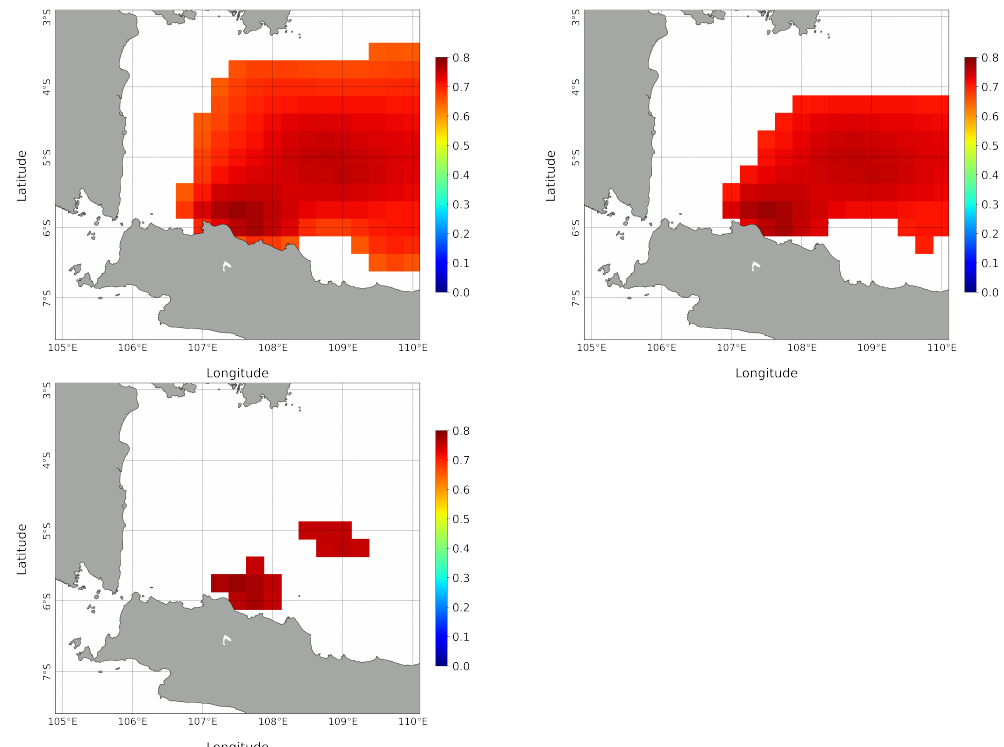
Figure 12. Spatial Correlation (SC) between the wind field and the wave data at the observation point, where CC > 0.65 (upper left plot), CC > 0.70 (upper right plot), and CC > 0.75 (lower